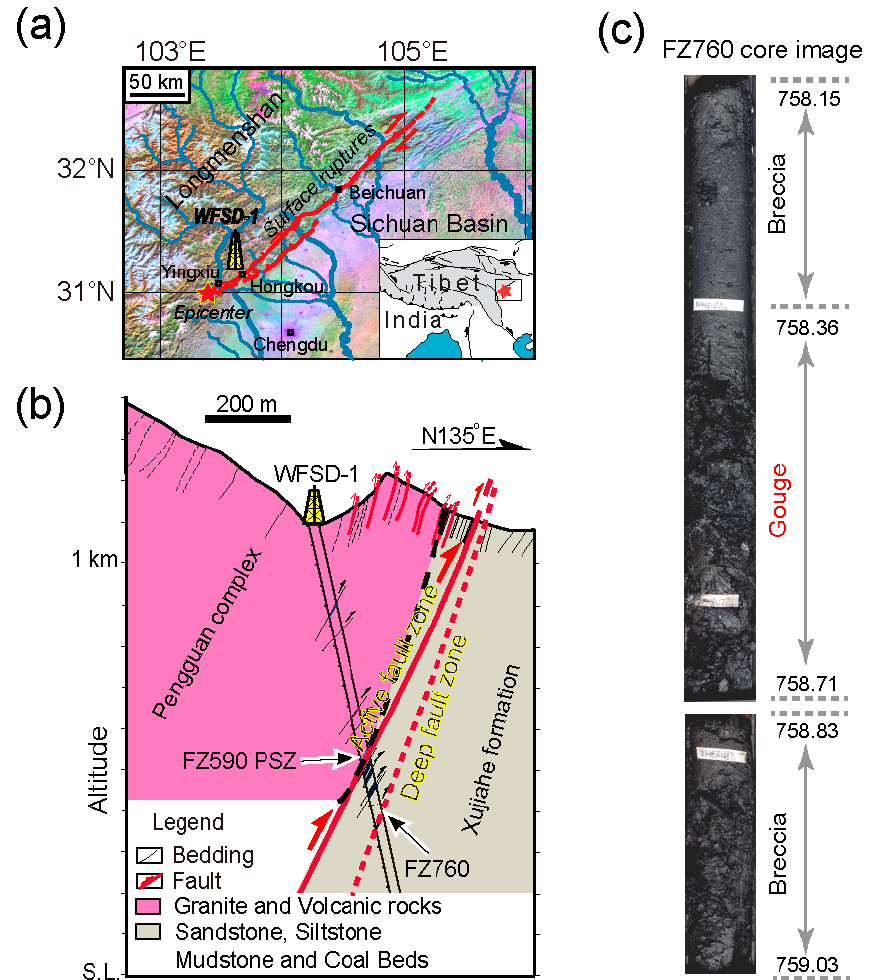
Figure 1. Shaded-relief map of the eastern Tibet showing the major Longmenshan fault belt, the 2008 Mw 7.9 Wenchuan earthquake, China, and the location of the Wenchuan earthquake Fault Scientific Drilling project-1 (WFSD-1) drilling site [19]. ( a ) The 240 km-long Yingxiu-Beichuan surface rupture and the 80 km-long Guanxian-Anxian surface rupture associated with the Mw 7.9 earthquake, and the location of WFSD-1 site. Red star is the epicenter of the main shock. Inset is a schematic plot of the Tibetan Plateau. ( b ) An N135°E cross-section of the WFSD-1 showing the Longmenshan fault system and surrounding formations encountered in the borehole. The upper arrow showing the 2008 earthquake principal slip zone located at 589.22 m depth. The lower arrow showing the bottom of the Longmenshan fault system located at 759 m depth (the target fault zone in this study), and the images of core samples of the WFSD-1 was enlarged in the right panel as ( c ). ( c ) The core image exhibiting